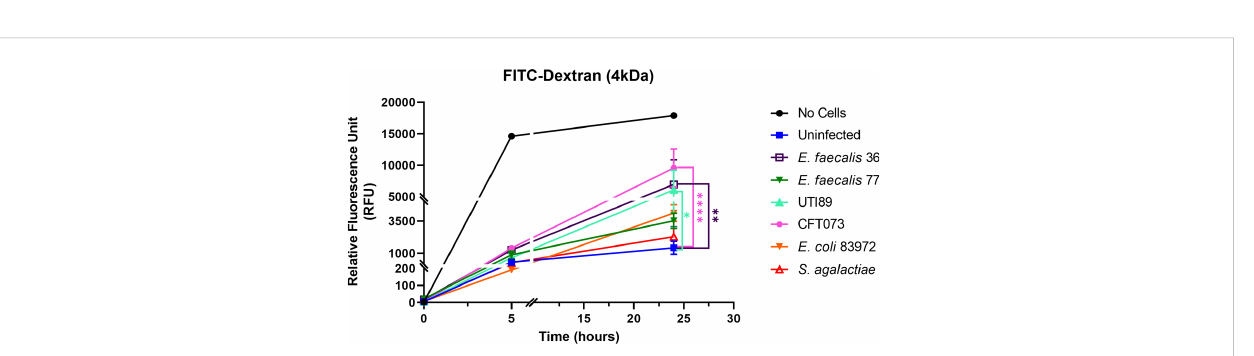
FIGURE 7 Uropathogens disrupt barrier integrity of 3D-UHU models. The barrier integrity in response to uropathogens (MOI 10) was measured by assessing the FITC-dextran in fl ux into the basolateral chamber at 5h and 24h p.i. Data represent mean ± SD, n=3 biologically independent experiments. **** p < 0.0001, ** p < 0.01, * p < 0.05 calculated by two-way ANOVA followed by Dunnett ’ s multiple comparisons